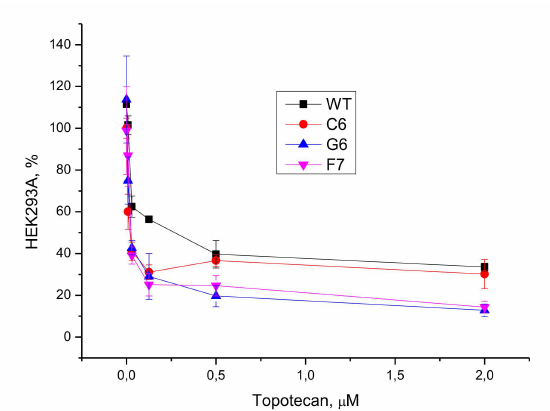
Figure 7. Topotecan (Tpc) cytotoxicity in HEK293A WT and TDP1 -/- knockout cell lines C6, G6 and F7—dose-dependent action of Tpc by colorimetric